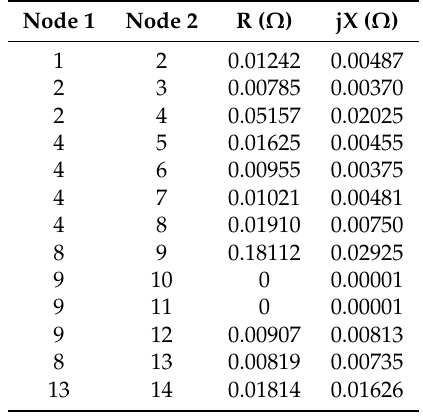
Table A2. Reactances of the system: Islanded operation